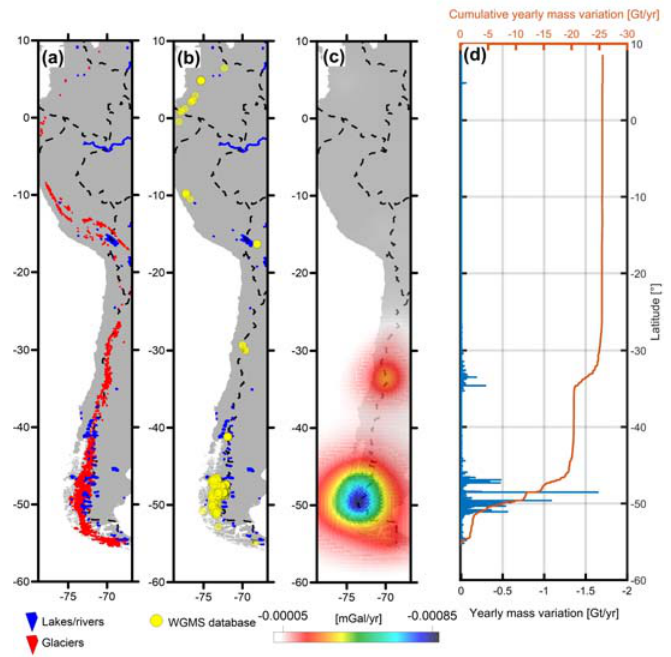
Figure 1. ( a ) Glaciers’ outlines according to the RGI database (red) and lakes (blue) in South America; ( b ) location of the glaciers with observed change rates in WGMS; ( c ) gravity signal at 250 km-altitude calculated from our ice thickness model; ( d ) yearly mass change for each RGI glacier according to our model (blue) and cumulative effect as function of latitude (in dark orange).